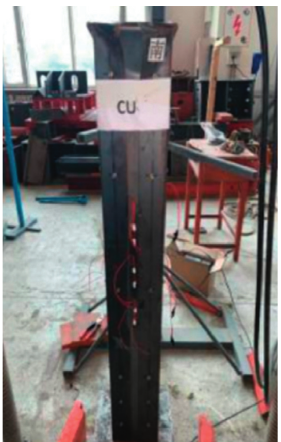
Figure 17: CU-1 failure